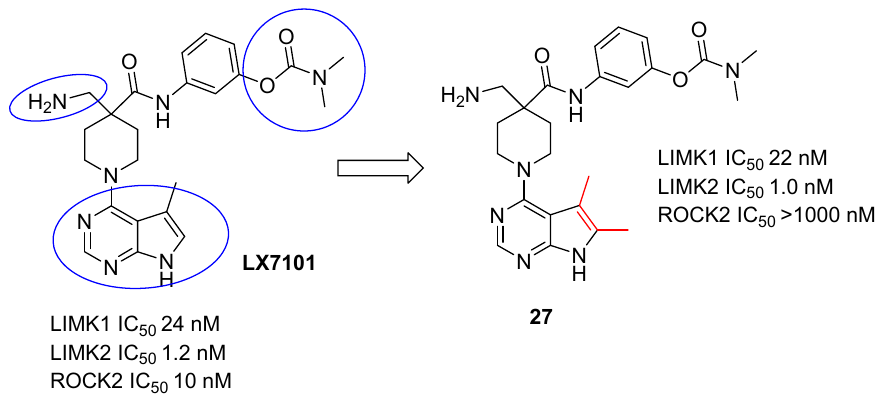
Figure 6. LX7101 modulation by Amakem Therapeutics.